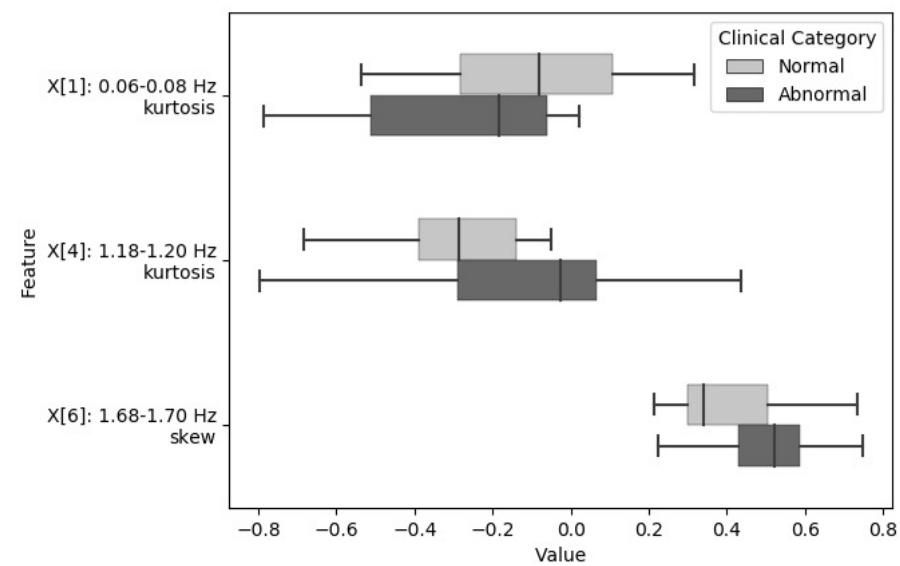
Figure 4. Statistical distribution of spectral features used for obstructive sleep apnea (OSA) detection grouped by clinical category.